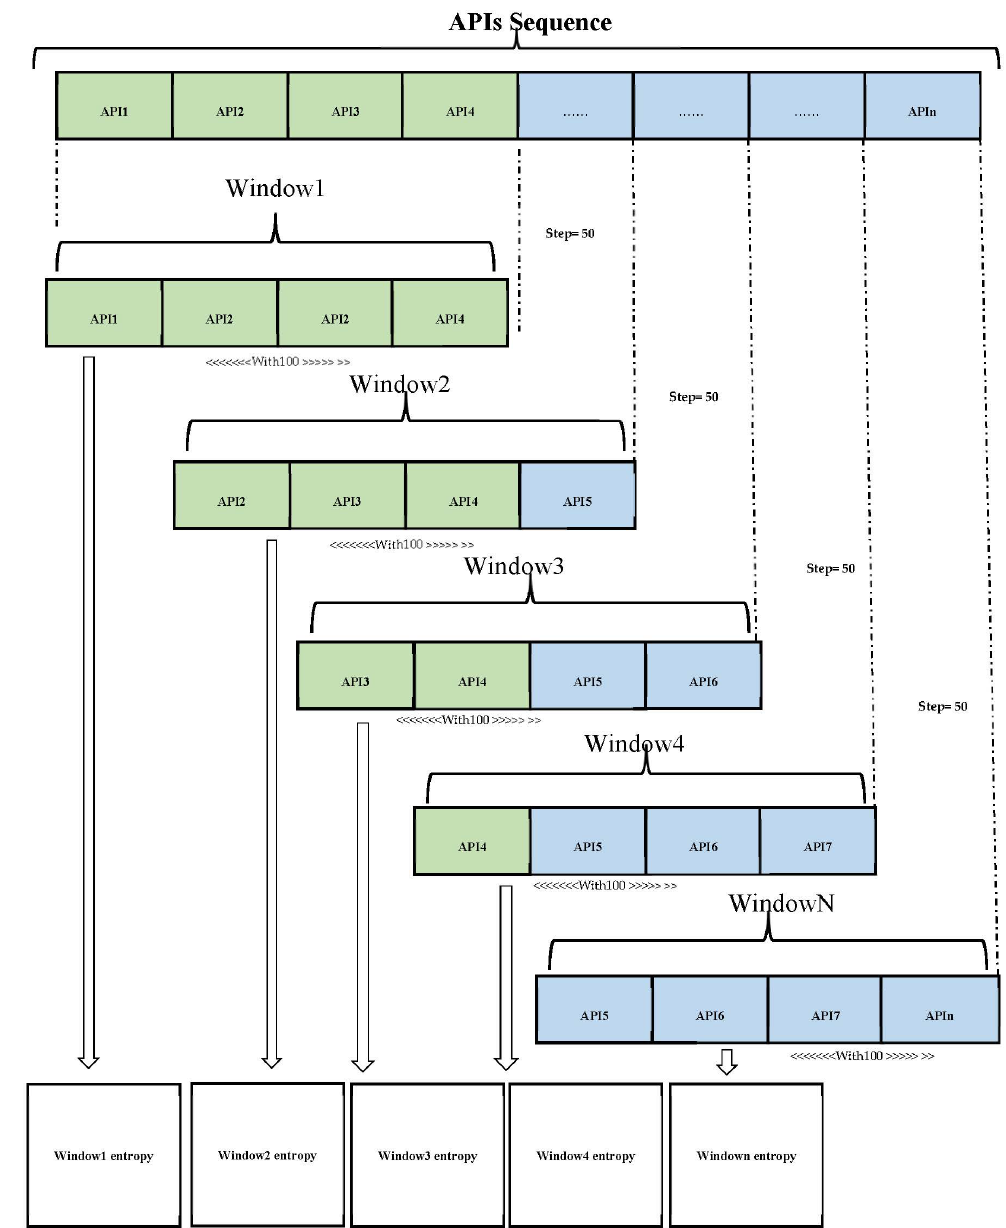
Figure 4. Entropy distribution representation.